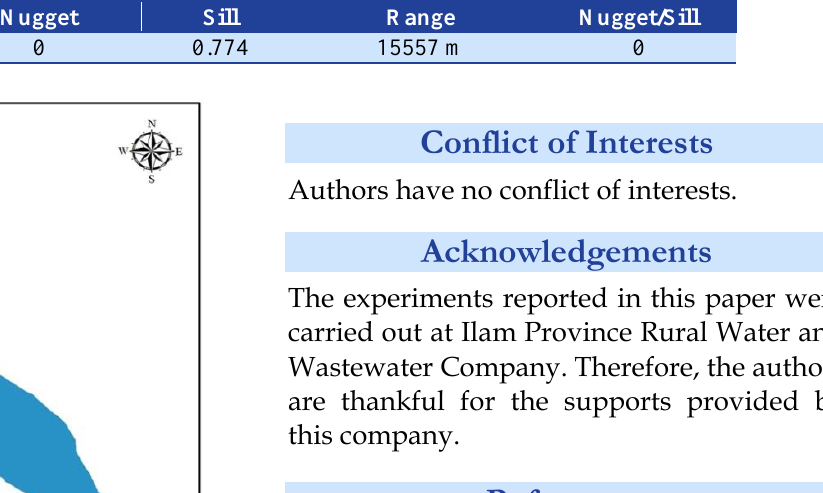
Table 3. Semivariance parameters for the groundwater phosphate concentrations